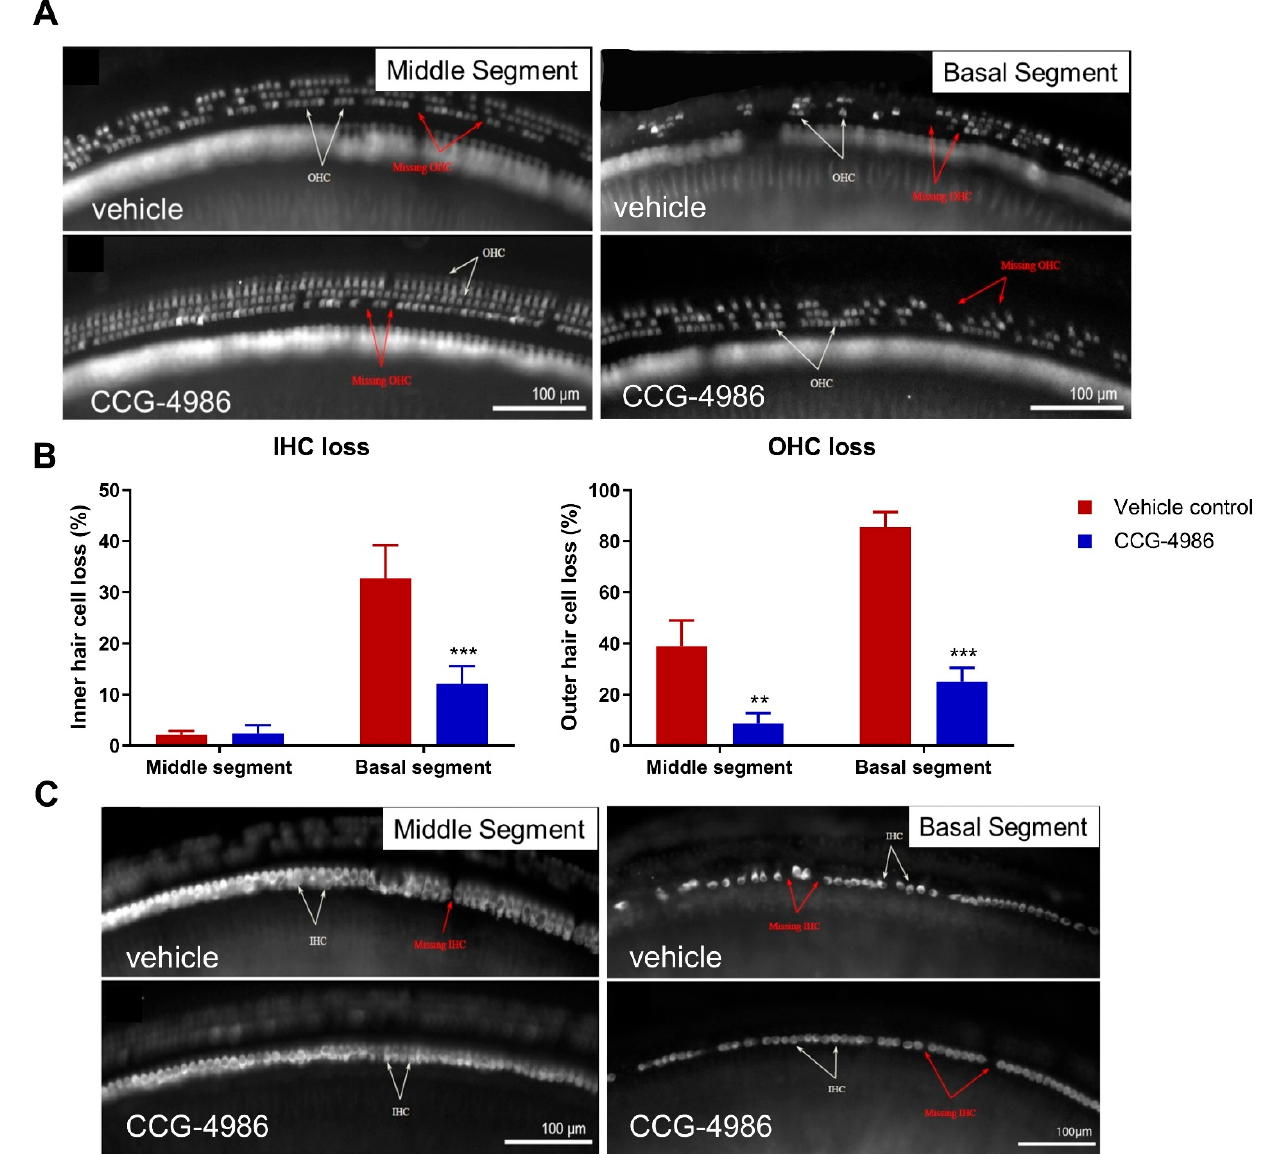
Figure 4. ( A ) Representative images of OHC in the middle and the basal segment of the cochlea in noise-exposed vehicle-treated and CCG-4986 treated animals. ( B ) Percentage of hair cell loss (OHC and IHC) in the middle and basal cochlear segments of vehicle- and CCG-4986 treated animals. Data presented as mean ± SEM, vehicle control n = 16, CCG-4986 n = 17. ** p <0.01, *** p < 0.0001; Two-way ANOVA followed by Holm–Sidak post-hoc test. ( C ) Representative images of IHC in the middle and the basal segment of the cochlea of vehicle-treated and CCG-4986 treated animals. White arrows point at the sensory hair cells and red arrows at spaces with missing hair cells.